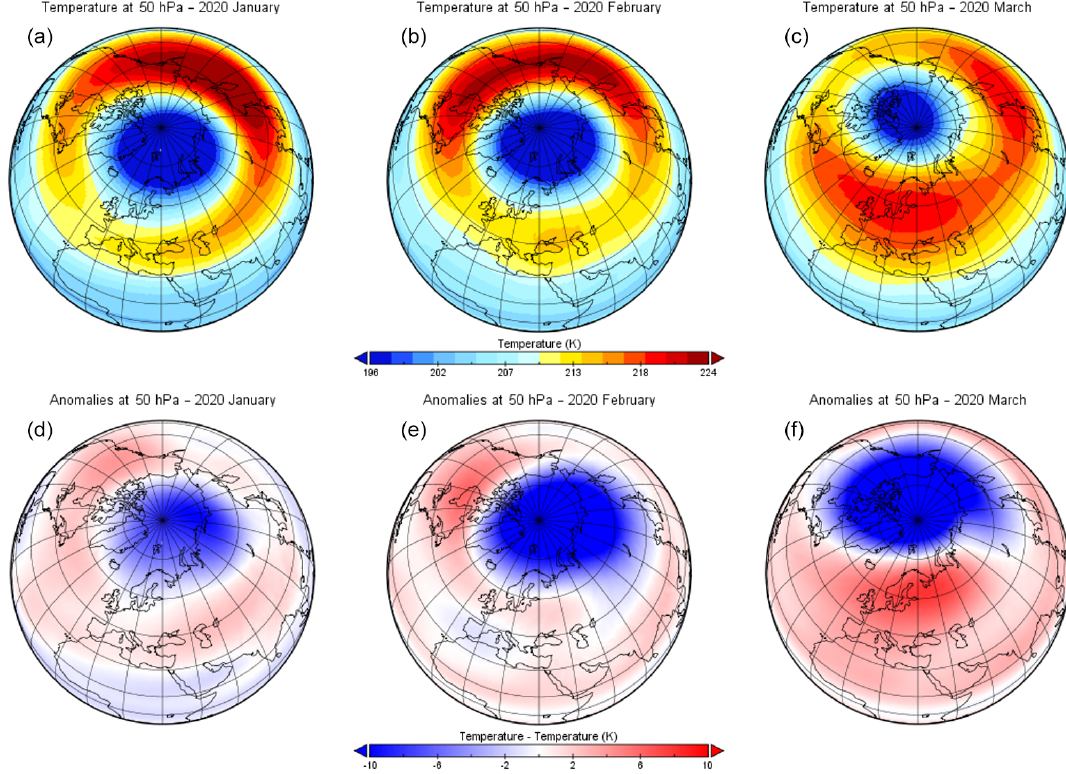
Figure 5. ERA5 monthly mean temperature at 50hPa (about 20km altitude) for January to March (columns 1 to 3) for year 2020 (a–c) and the corresponding temperature anomalies (d–f) with respect to the average from 1979–2019, showing negative differences of up to − 9.93K in January, − 18.44K in February, and − 23.83K in March